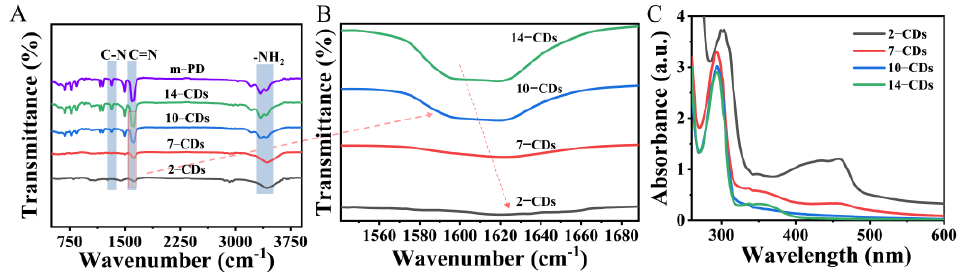
Figure 3. ( A ) FTIR spectrum of 2–CDs, 7–CDs, 10–CDs, 14–CDs and m − PD (the red arrow means to enlarge this part). ( B ) a magnified view of the C=N position in the FTIR spectrum of 2− CDs, 7 −CDs, 10−CDs and 14− CDs (the red arrow represents the red-shifts). ( C ) UV absorption spectrum of 2− CDs, 7 −CDs, 10−CDs and 14− CDs.